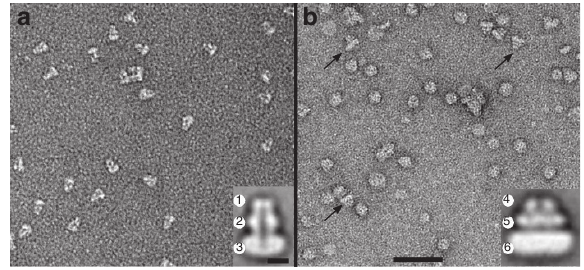
Figure 2 | TEM observations of OprM and MexB reconstituted into nanodiscs. ( a ) Field of view of OprM–ND showing side views of isolated molecules. The average image (inset) reveals characteristic features: The OprM b -barrel in the ND (1) and the OprM periplasmic domain composed of the equatorial domain (2) and the tip of the a -barrel (3) protruding from the ND. ( b ) Field of view of MexB-ND showing isolated molecules. Black arrows indicate side views. On the average image (inset), a side view of MexB exhibits the periplasmic part organized in two layers (funnel (4) and porter (5) domains) protruding from the ND (6). Scale bars, 50nm and 5nm for the inset. a.u., arbitrary unit.